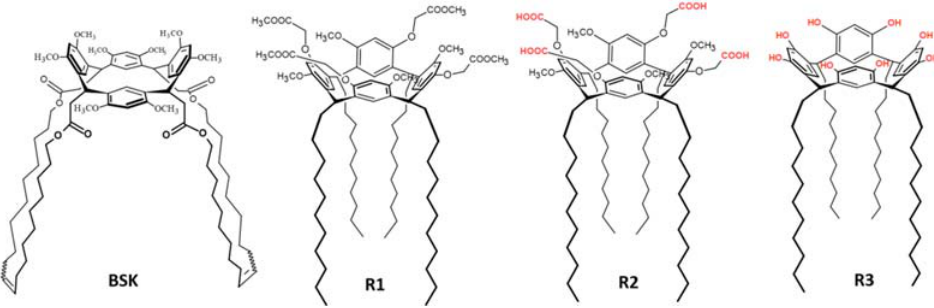
Figure 4. 3D chemical structure of BSK and of amphiphilic resorc[4]arenes R1 , R2, and R3 .